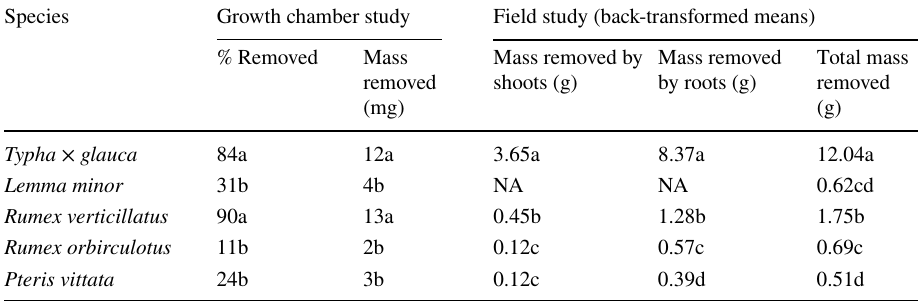
Within columns; means represented by statistically significant differences ( p < 0.05) have different letters following the numerical